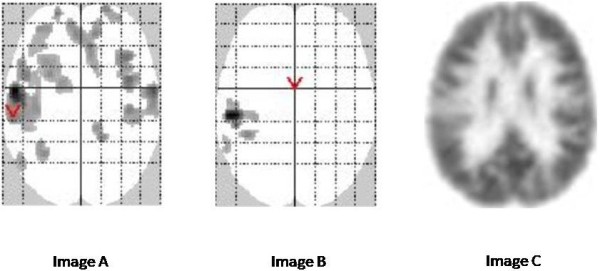
Comparative results using SPM-A, SPM-P, and visual analyses. Comparative results using SPM-A (adult control group), SPM-P (pediatric pseudo-control group) and visual analyses in a 4 year old patient. In this 4-year-old patient with positive MRI and seizure onset zone (SOZ) in the left insula, visual analysis (image C) shows a left insular hypometabolic area (axial slice). SPM-P (image B, SPM glass brain) identifies a hypometabolic cluster in the same area. SPM-A (image A, SPM glass brain) also identifies this cluster, but also shows several additional hypometabolic artifacts mainly located within the frontal cortex, ipsi- and contralaterally.